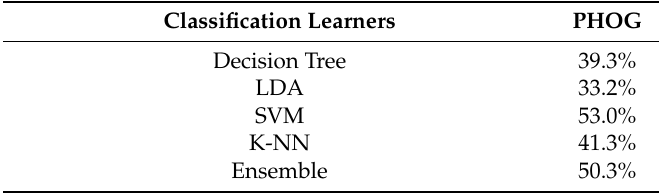
Table 5. Accuracy of PHOG based on different machine-learning classifiers.